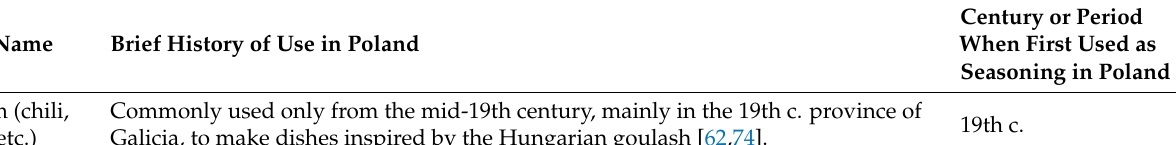
Table 6. A brief history of the use of spices and herbs in Poland (we included the species mentioned by at least 10% of the informants). For the scientific names of the plants see Table